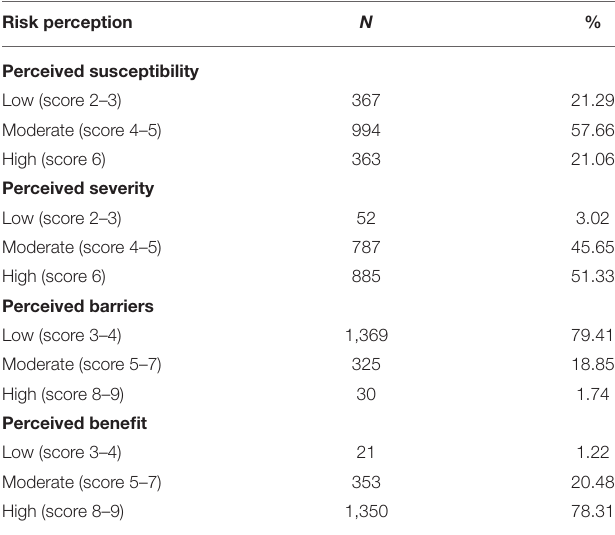
Table 3 . Without controlling for any confounding factor in model A, booster dose acceptance was associated with a